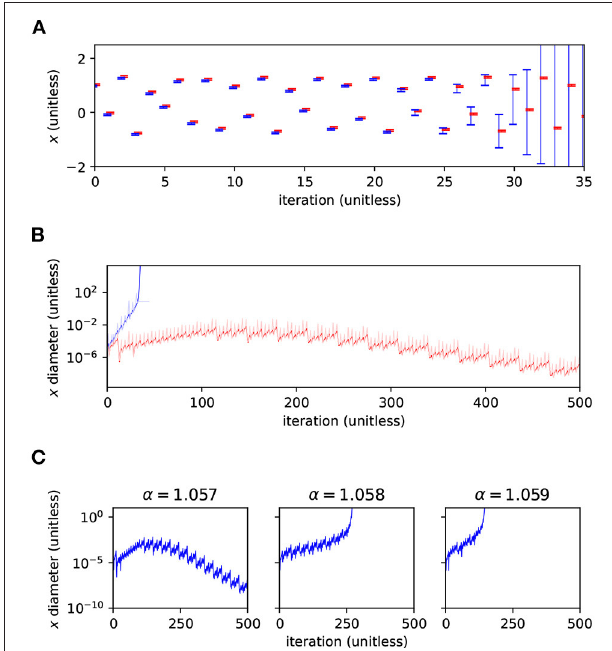
FIGURE 2 | Range analysis of the Hénon map’s x variable. (A) Values of x and the range (errorbars) computed by Arpra using plain AA (red), and by MPFI using IA (blue). Note that the symbols were offset diagonally to make them visible where they coincide. (B) Diameter of the range, in log scale, for 500 iterations (red, blue) and the diameter relative to the magnitude of the range’s centre (light red, light blue). Note how the IA ranges begin to explode at around i 30, while the AA ranges shrink after a short growth period. = α 1.057 and β 0.3 in (A,B) . (C) Diameter (log scale) of the x range = = computed using Arpra’s plain AA method for α 1.057 (left), α 1.058 = = (centre) and α 1.059 =